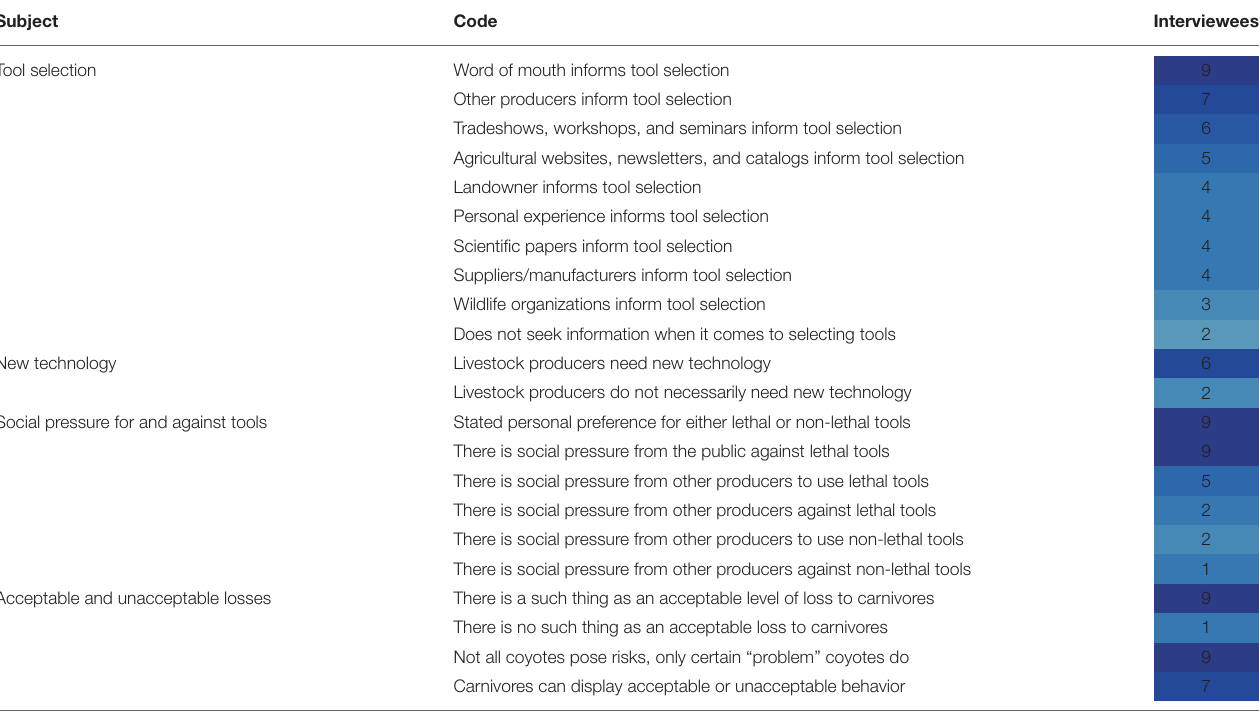
TABLE 2 | How producers make livestock management